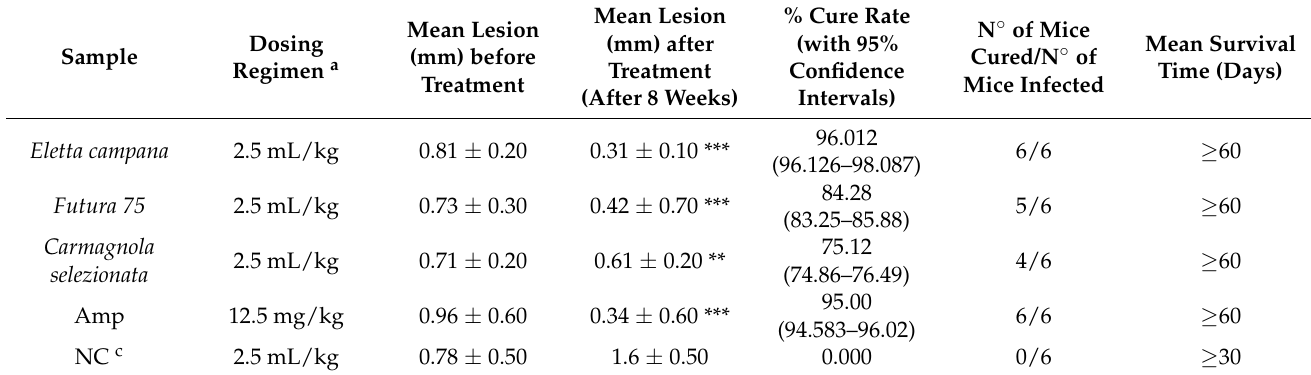
Table 6. Protective effects induced by the hemp essential oils on tissue wound induced by L. tropica challenging, in vivo. Data are expressed as means ±